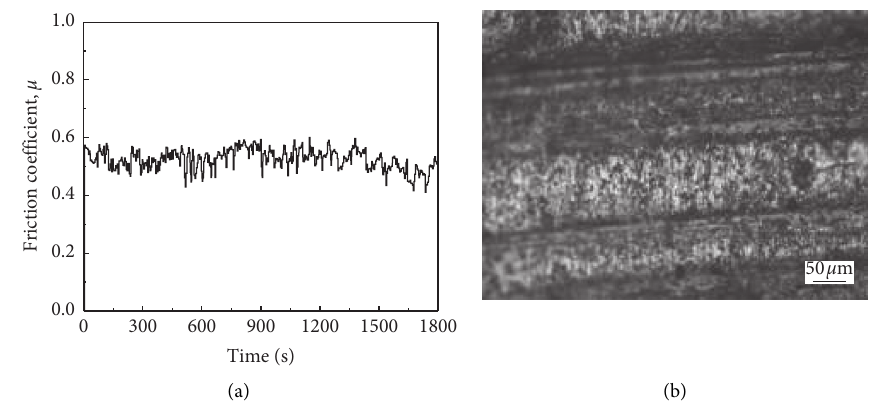
Figure 16: Friction coefficient and worn morphology of S2 coating at 800 ° C.